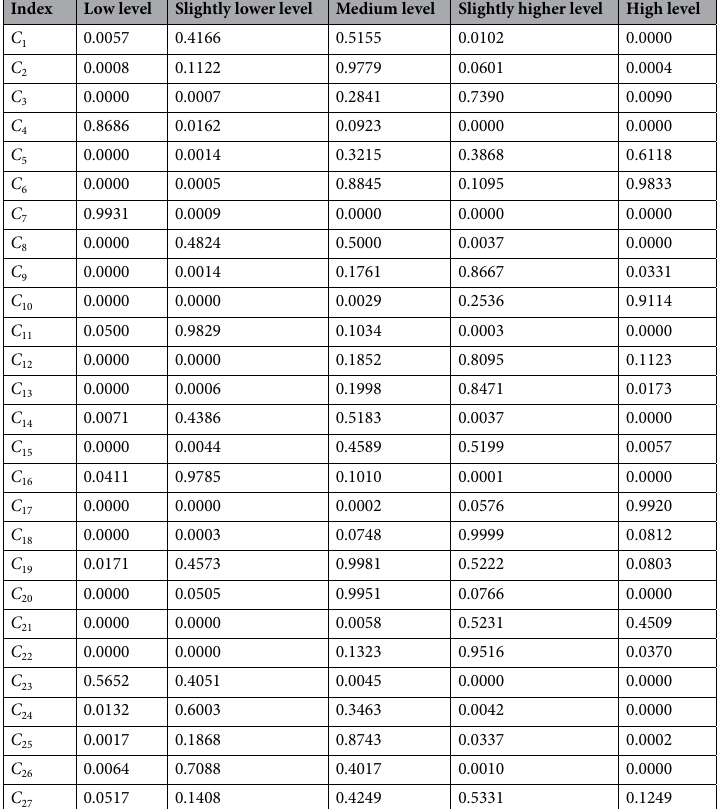
Table 10. Evaluation index: average membership of normal